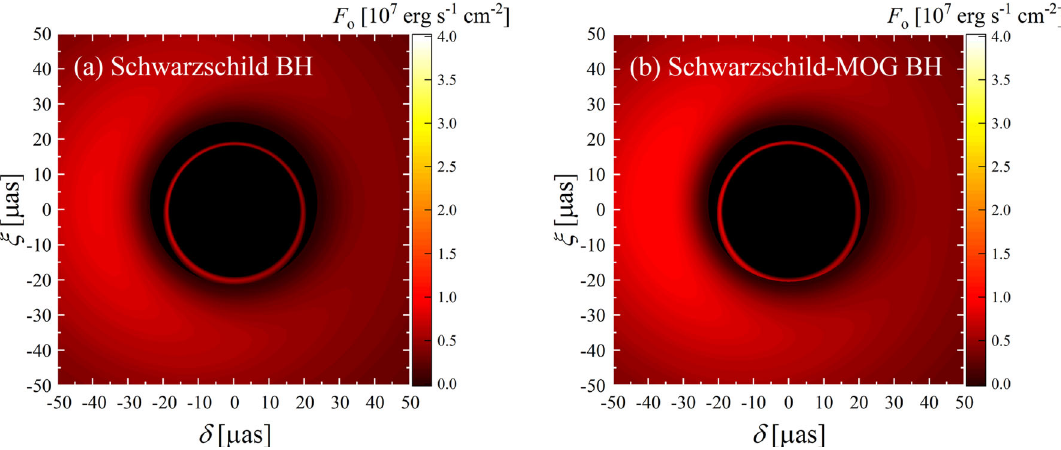
17 ◦ and 5 kpc, respectively. Evidently, the Schwarzschild BH is